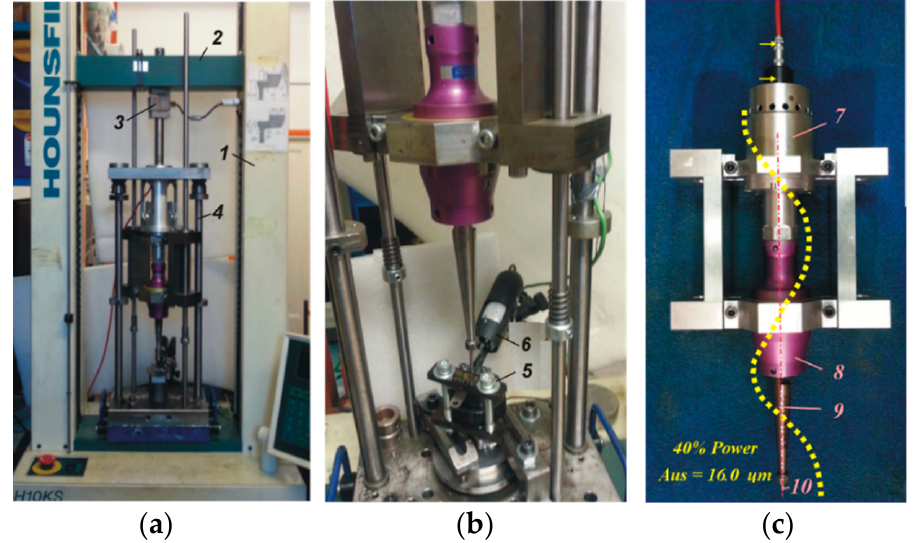
Figure 1. The experiment stand: ( a ) Overview; ( b ) Close-up of the working area; and ( c ) The ultrasonic system. Legend: (1) the testing machine; (2) the ram; (3) the force transducer; (4) the die set; (5) the micro-die set; (6) the camera; (7) the ultrasonic transducer; (8) the booster; (9) the sonotrode; and (10) the punch. measure the amplitude of vibrations on the face of the